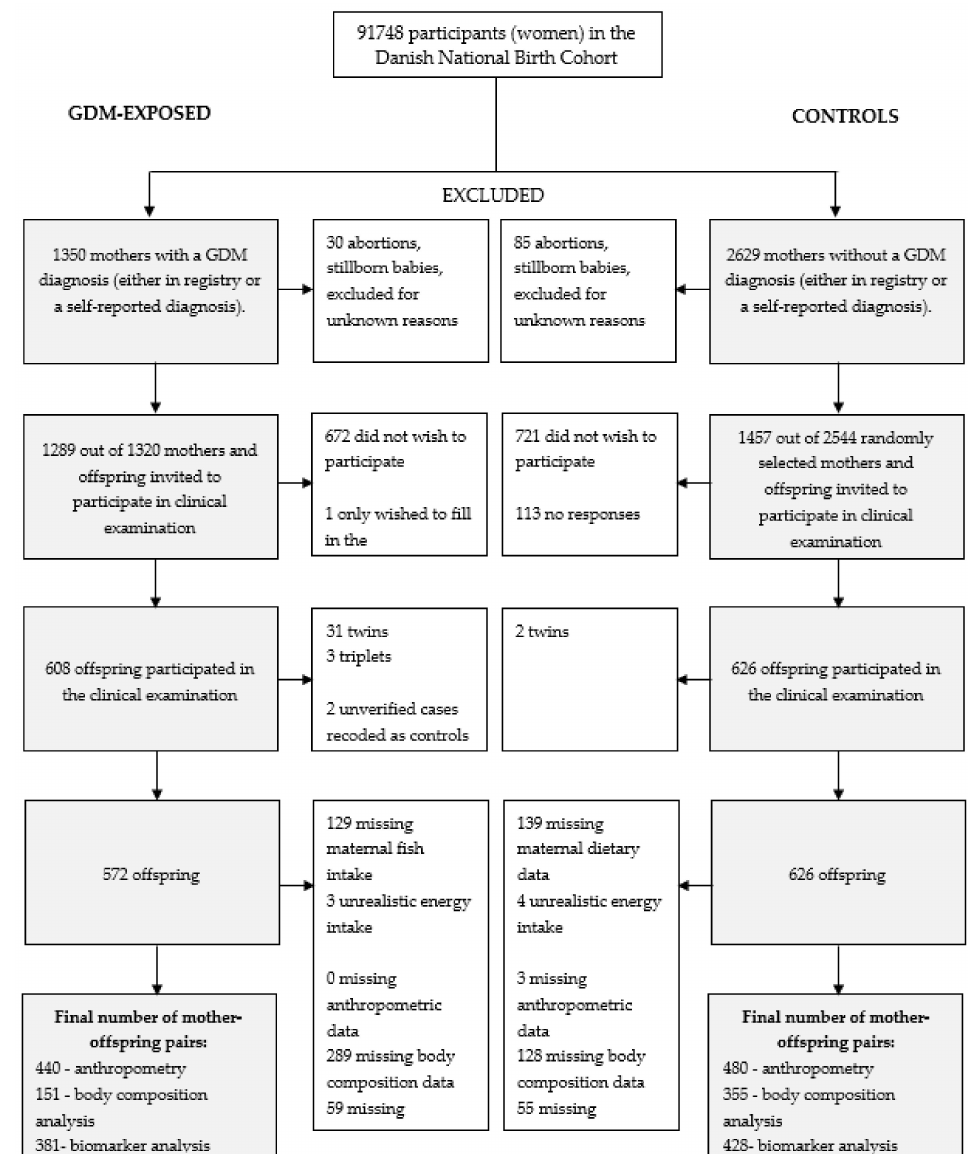
Figure 1. Study population flow (Each woman was defined as either a case or a control in all her pregnancies, thus, redefining some control pregnancies to case pregnancies. A woman who participated with more than one pregnancy was defined as a case if she had had at least one case pregnancy, regardless if the case pregnancy was the first one or not. Initially, there were approximately 50 women with pregnancies defined as both cases and controls; these pregnancies were redefined as cases. Women who only had pregnancies that ended with abortions or stillborn babies were